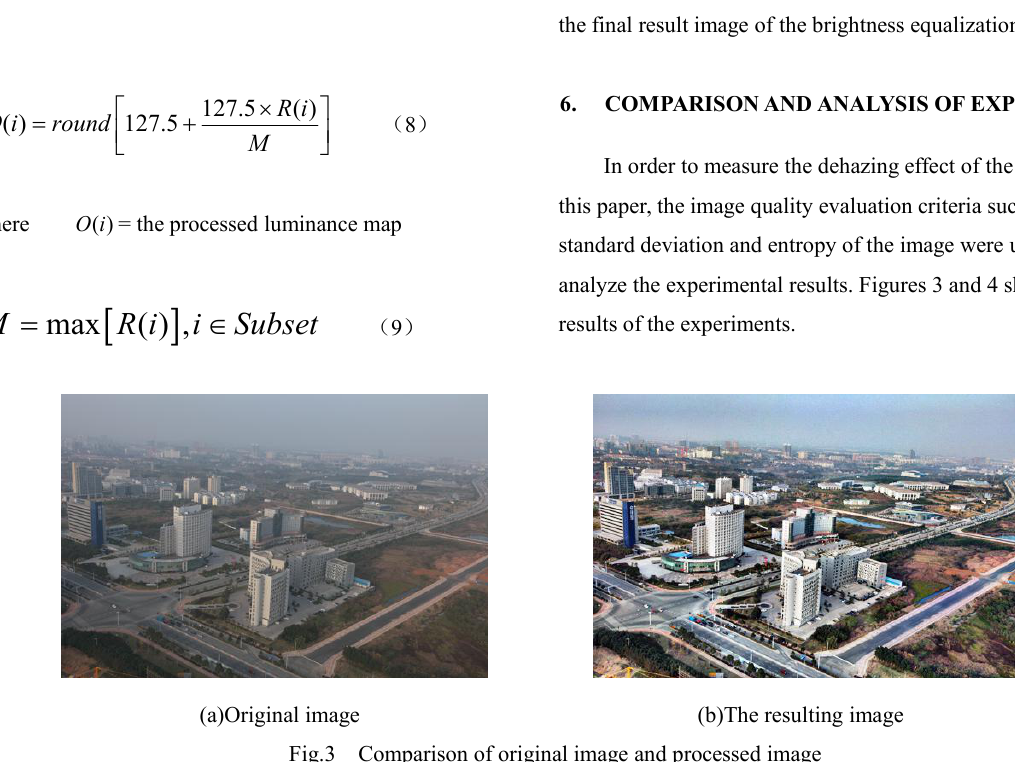
Fig.3 Comparison of original image and processed